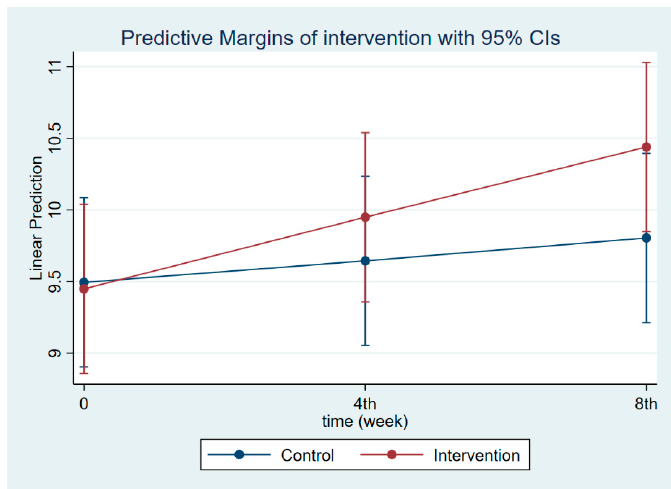
Figure 8. Children’s body weight at follow-ups 1 and 2.